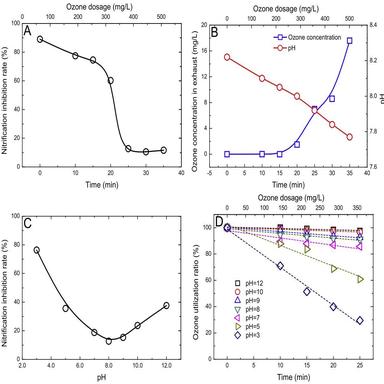
Effect of reaction time on nitrification inhibition rate (A) and ozone concentration in exhaust and pH in effluent wastewater (B); Effect of pH on nitrification inhibition rate (C) and ozone utilization ratio (D).